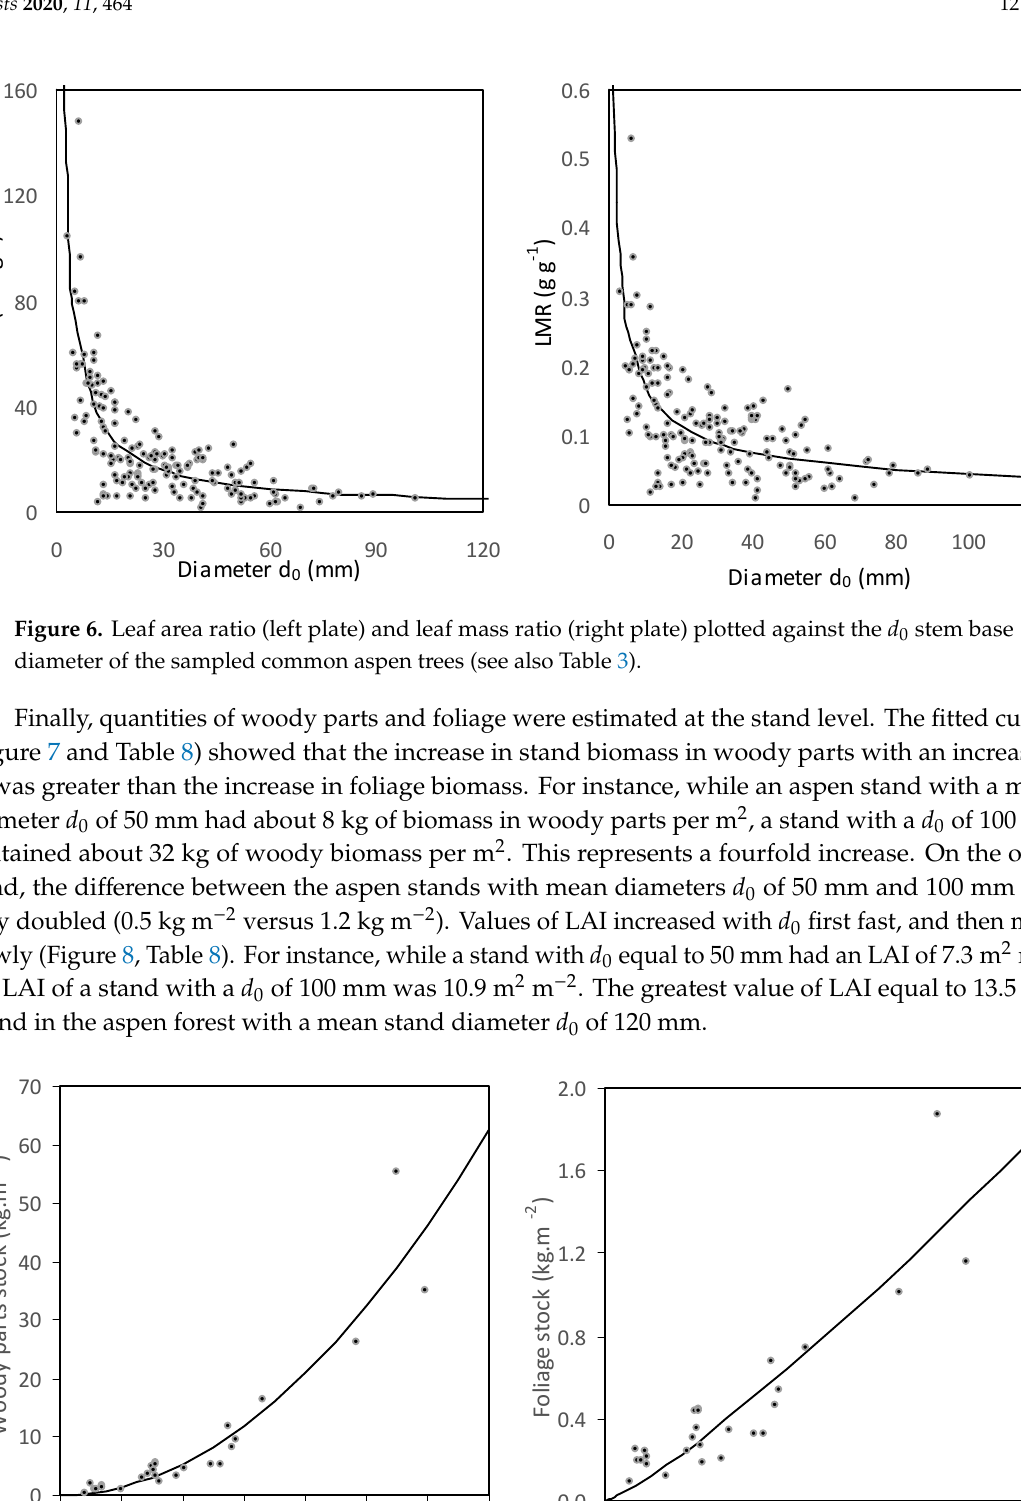
Figure 7. Stand biomass of woody parts (left plate) and foliage (right plate) in common aspen fully-stocked stands plotted against the d 0 mean stand diameter at the stem base (see also Table 8).